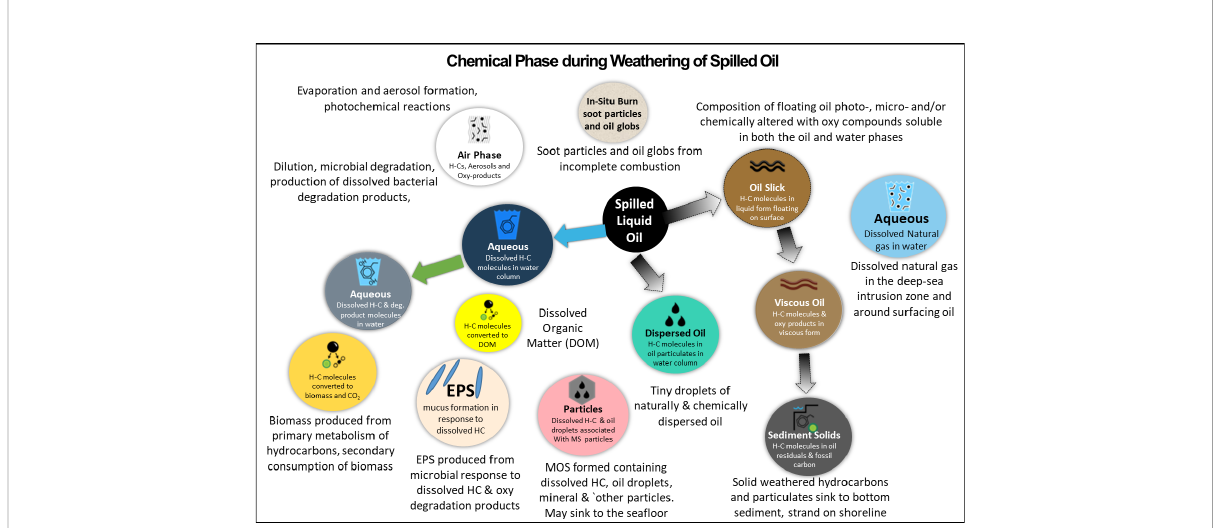
FIGURE 6 Weathering encountered by spilled oil in different physical phases (gases, liquids, solids) in the marine environments following a well blowout. Remedial actions in fl uence the partitioning into the different phases and the subsequent fate of the spilled oil. The fi gure does not include a possible methane hydrate solid phase that may develop in deep water. The term biomass refers to all living organisms in the marine environment as well as those organisms produced from metabolism of the spilled oil